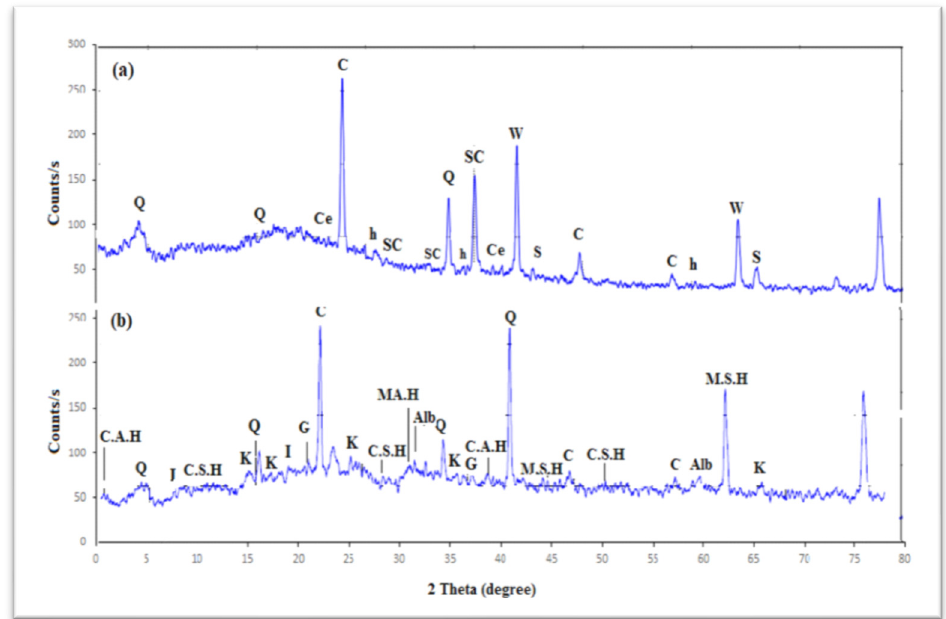
Figure 4. ( a ) X-ray diffraction (XRD) spectrum of nB (Q is quartz; S is sylvite; C is calcite; Ce is cellulose; SC is sodium carbonate; W is whitlockite; and h is hydrozincite). ( b ) X-ray diffraction (XRD) spectrum of nWTR; (Q is quartz; C is calcite; K is Kaolinite; I is illite; G is goethite; C.A.H is calcium aluminate hydrate; C.S.H is calcium silicate hydrate; M.A.H is magnesium aluminate hydrate; and C.S.H is calcium silicate hydrate).